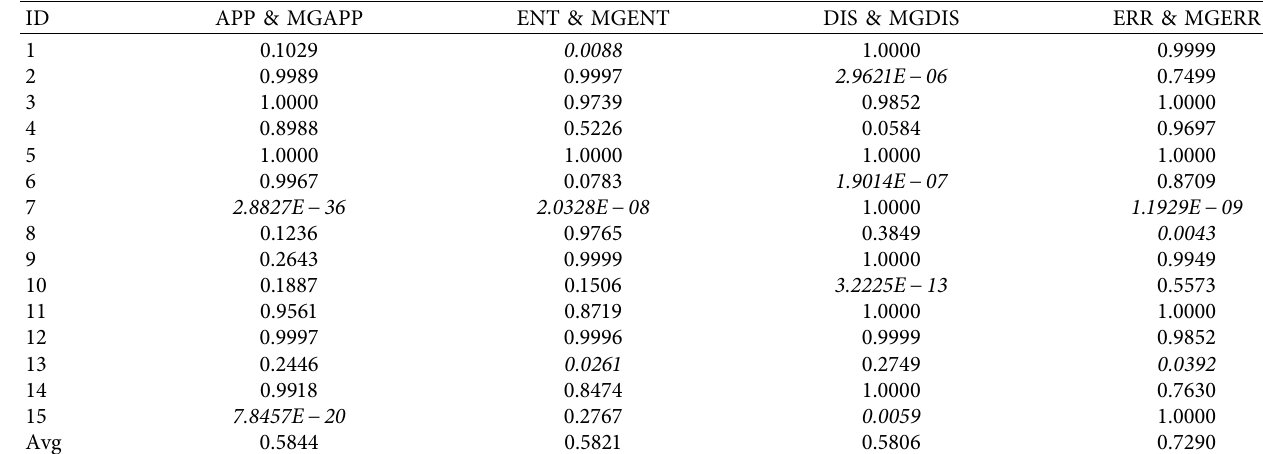
Table 9: Comparisons of the distributions with using